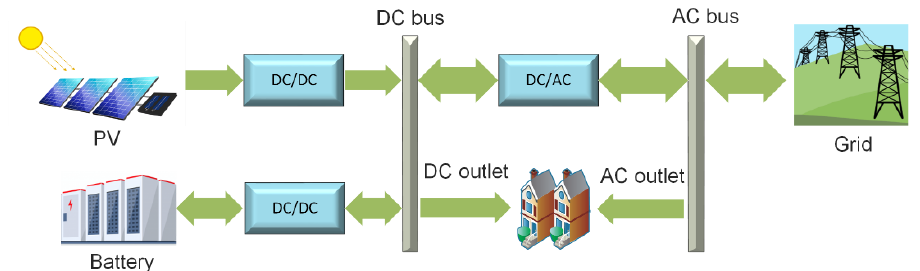
Figure 3. PV–battery grid-connected system.